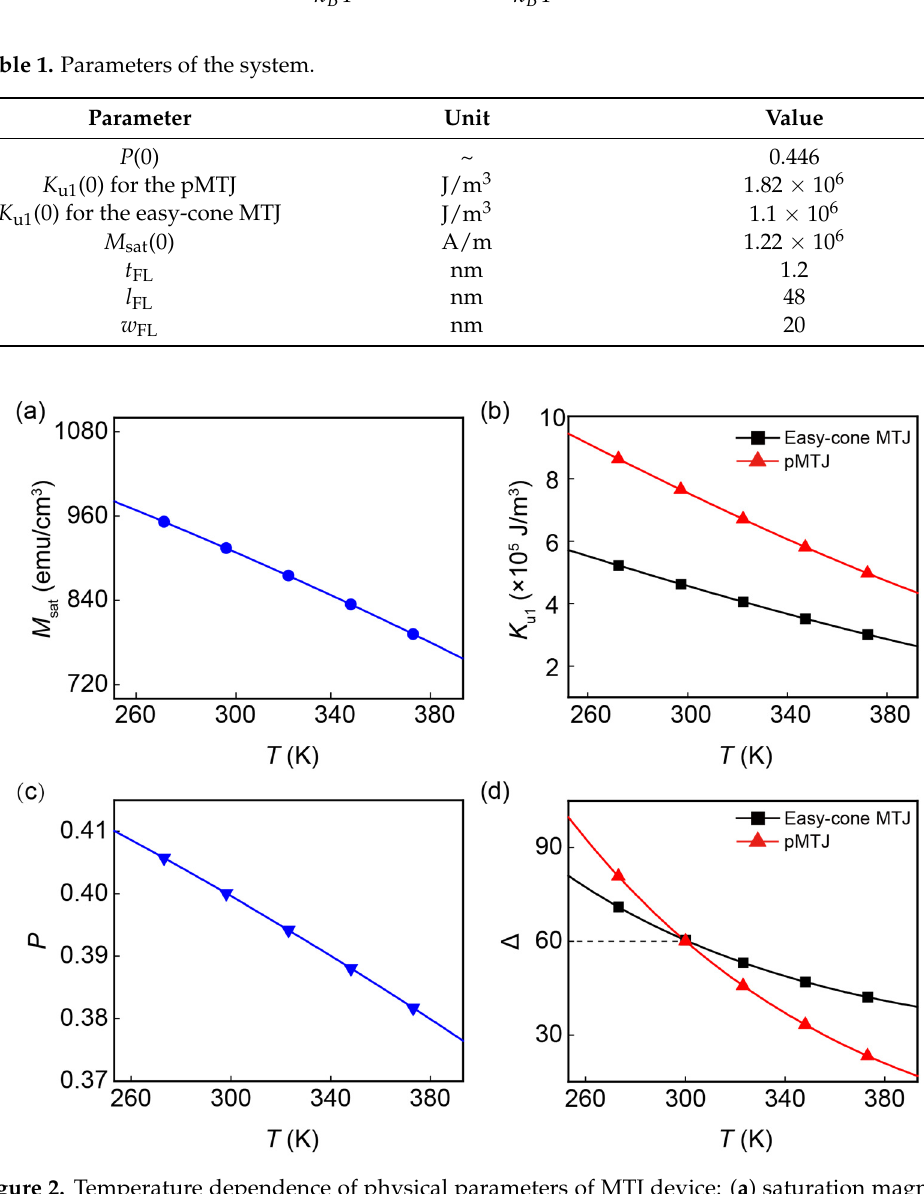
Figure 2. Temperature dependence of physical parameters of MTJ device: ( a ) saturation magnetization M sat , ( b ) first order anisotropy constant K u 1 , ( c ) spin polarization factor P , and ( d ) thermal stability Δ . Both devices have Δ = 60 at room temperature. Table 1. Parameters of the system.